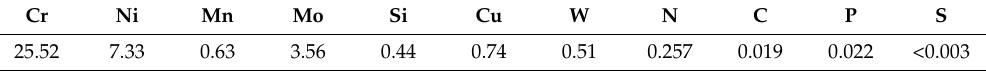
Table 1. Chemical composition of the UNS S32760 superduplex stainless steel (wt % balance Fe). Cr Ni Mn